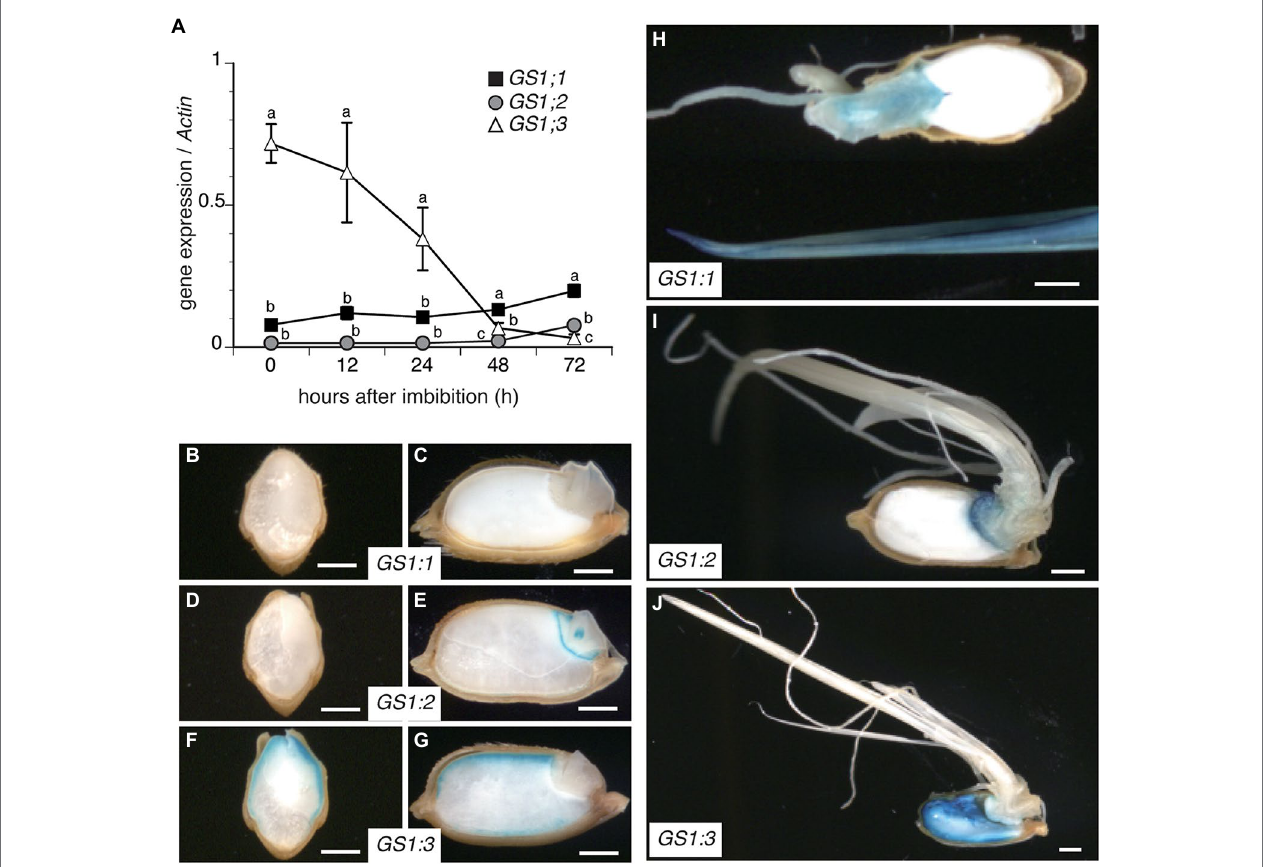
FIGURE 1 | Differential expression and localization of cytosolic glutamine synthetase (GS1) genes during rice seed germination. (A) Time course qPCR analysis of GS1 isoforms in WT plants during rice seed germination after imbibition of mature seeds. Data represent mean ± SD ( n = 3). (B–J) GS1 promoter-driven GUS activity in germinating rice seeds. Transgenic rice seeds harboring GS1;1pro::GUS , GS1;2pro::GUS , or GS1;3pro::GUS construct were germinated and cultured under controlled conditions for 72 h. Transverse (B,D,F) and longitudinal (C,E,G) sections of seeds expressing GS1;1 (B,C,H) , GS1;2 (D,E,I) , and GS1;3 (F,G,J) . Images of seeds and seedlings were captured using a stereomicroscope at 24 h (B–G) and 72 h (H–J) after imbibition. Bars indicate 1